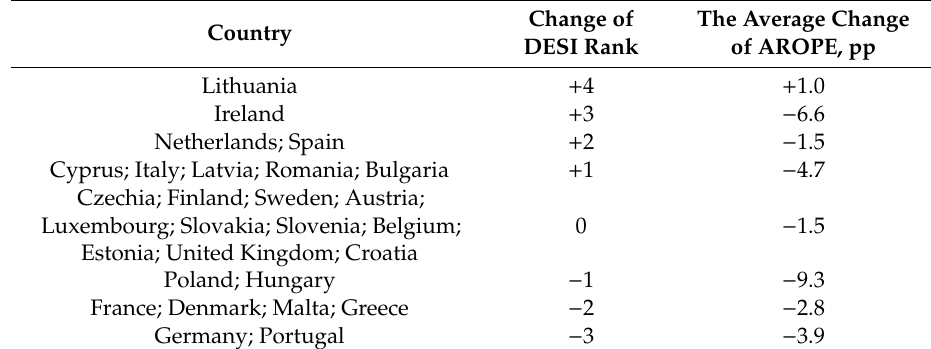
Table 8. Comparing the Change in the DESI Ranking and the Percentage of the Population by the AROPE Indicator in 2014–2018.